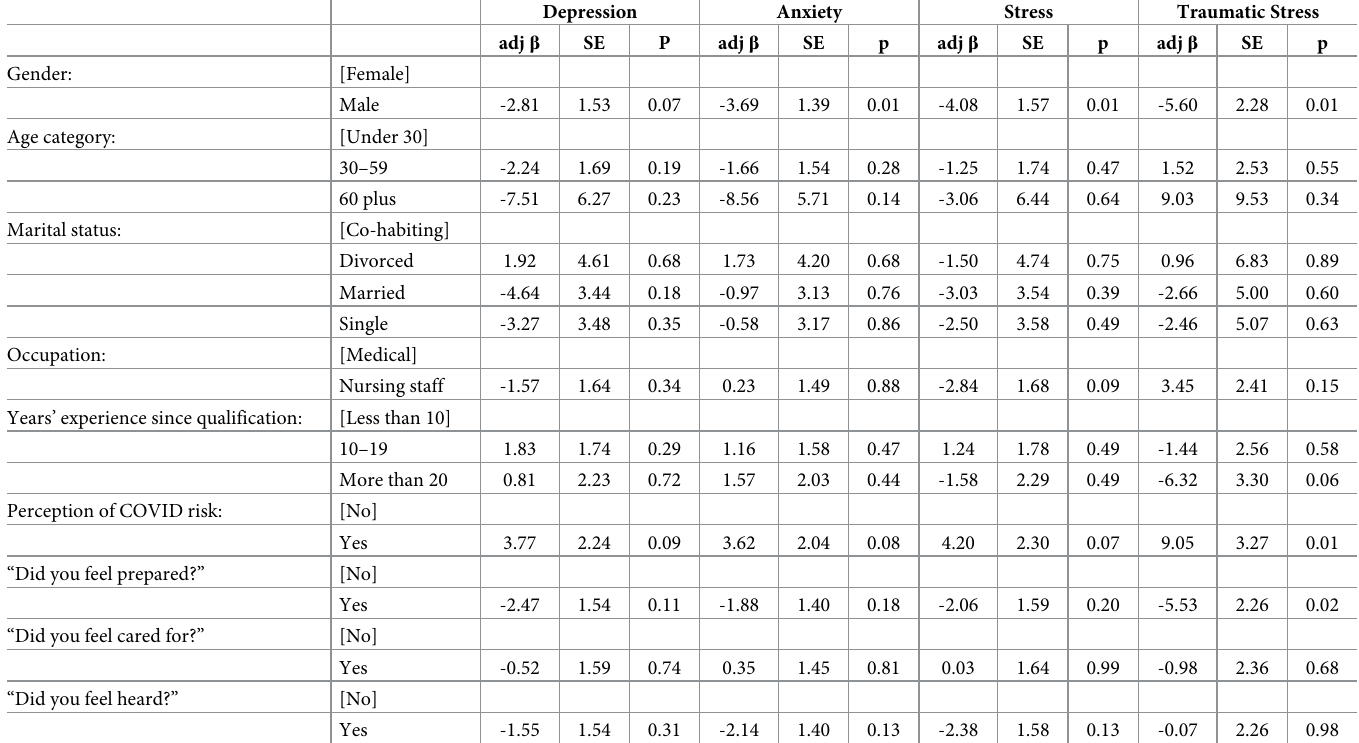
Table 3. Regression results on predictors of mental